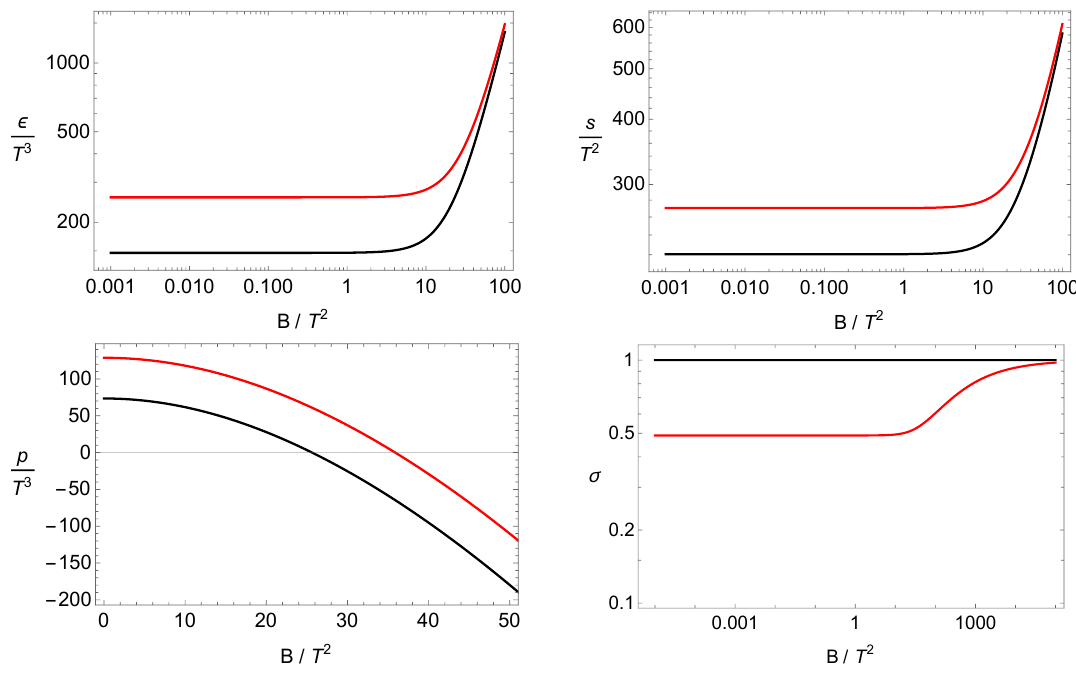
Figure 7 . Thermodynamic parameters ( (cid:15), p, s ) and conductivity σ from weak to strong magnetic field at µ/T = 0 , 5 (black,